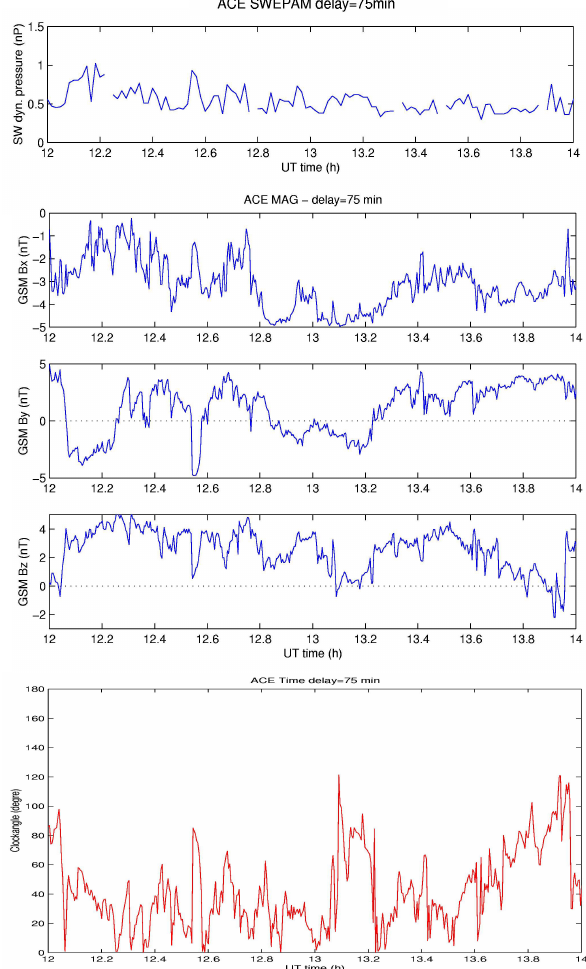
Fig. 3b. Detailed ACE data, shifted by a time-lag of 75 min as determined in Fig. 3a, from 12:00 to 14:00 UT on 14 January 2001. (From top to bottom: solar wind dynamic pressure, IMF X , Y and Z components in GSM coordinates, and IMF clock